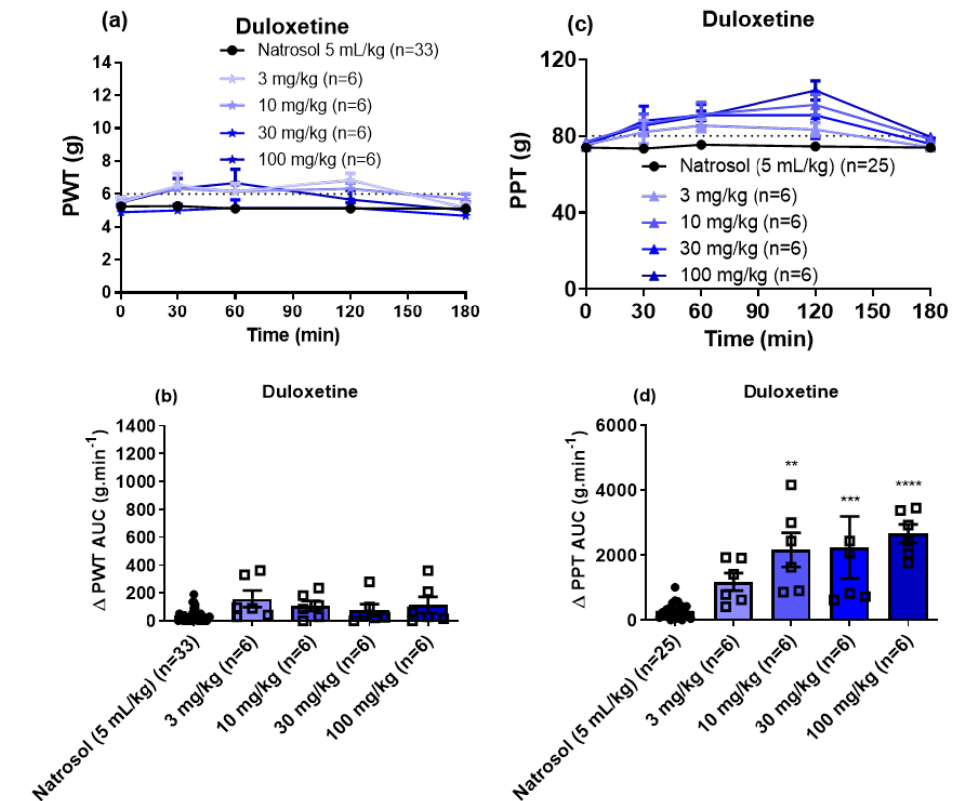
Figure 5. ( a ) Mean ( ± SEM) paw withdrawal threshold (PWT) versus time curves. ( b ) Scatter diagrams of the mean ( ± SEM) extent and duration of action quantified as the mean ( ± SEM) areas under the ∆ PWT versus time curves ( ∆ PWT AUC values) for the combined left and right hindpaws of individual CIPN-rats following the administration of single oral bolus doses of duloxetine at 3 mg/kg (n = 6), 10 mg/kg (n = 6), 30 mg/kg (n = 6) and 100 mg/kg (n = 6) relative to vehicle (n = 33). The horizontal dotted line in Panel ( a ) indicates fully developed mechanical allodynia (PWT ≤ 6 g) in the bilateral hindpaws. ( c ) Mean ( ± SEM) paw pressure threshold (PPT) versus time curves. ( d ) Scatter diagrams of the mean ( ± SEM) extent and duration of action quantified as the mean ( ± SEM) areas under the ∆ PPT versus time curves ( ∆ PPT AUC values) for the combined left and right hindpaws of individual CIPN-rats following the administration of single oral bolus doses of duloxetine at 3 mg/kg (n = 6), 10 mg/kg (n = 6), 30 mg/kg (n = 6) and 100 mg/kg (n = 6) at time 0 (pre-dosing) relative to vehicle (n = 25). The horizontal dotted line in Panel ( c ) indicates fully developed mechanical hyperalgesia (PPT ≤ 80 g) in the bilateral hindpaws. ** p < 0.01, *** p < 0.001 and **** p < 0.0001.